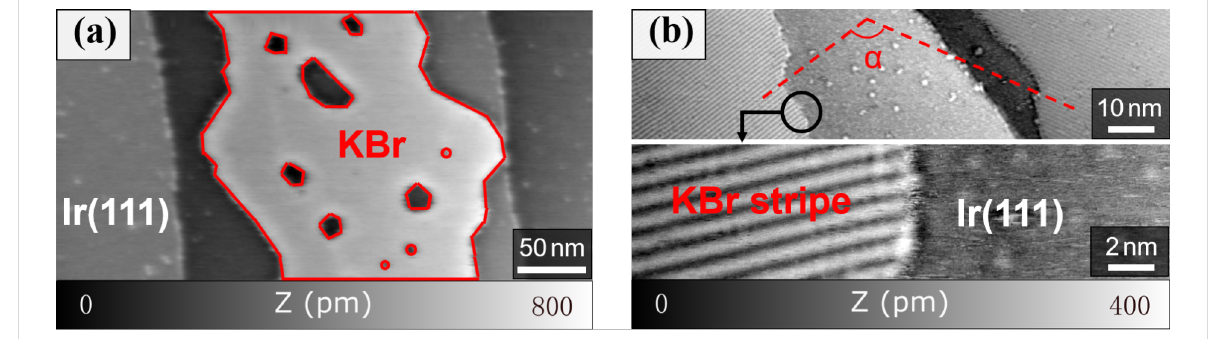
Figure 1: Reconstructed KBr on the Ir(111) surface. (a) Large-scale KBr island with irregular shape ( A 1 = 5 nm, Δ f 1 = − 4 Hz, γ = − 13.7 pN·nm 1/2 ). (b) Two different KBr domains with clear line structure and a zoom-in at one of the KBr edge regions ( A 1 = 2 nm, Δ f 1 = − 25 Hz, γ = − 21.6 pN·nm 1/2 ).